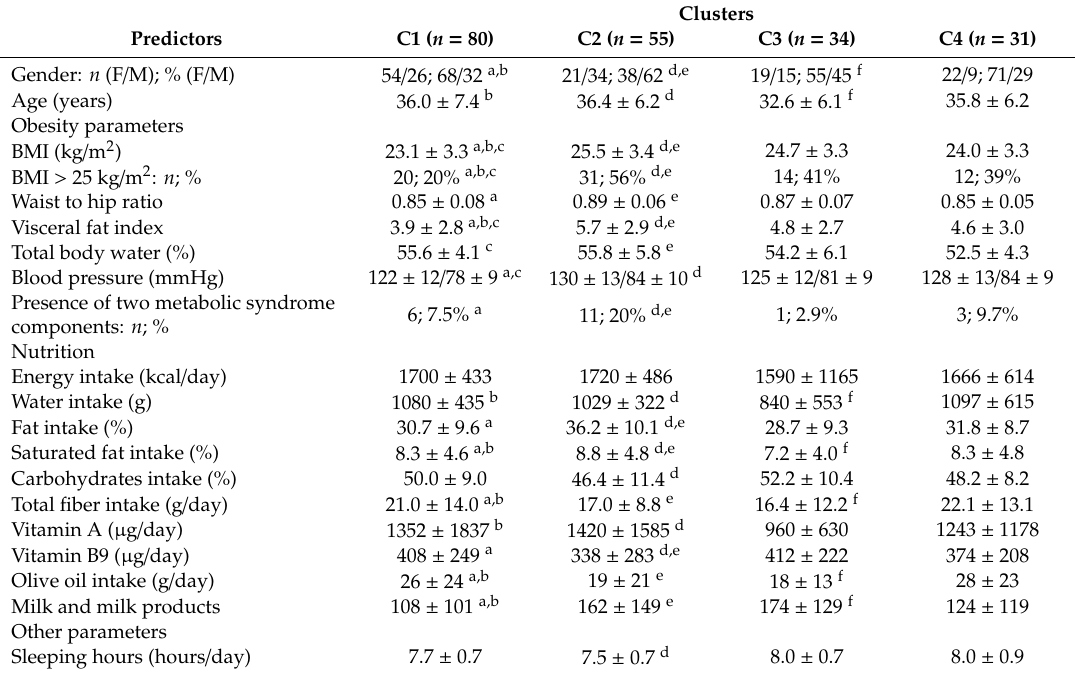
Table 3. Di ff erences in the top ten predictors (gender, obesity parameters, energy intake, physical activity, and nutrient intakes) between four